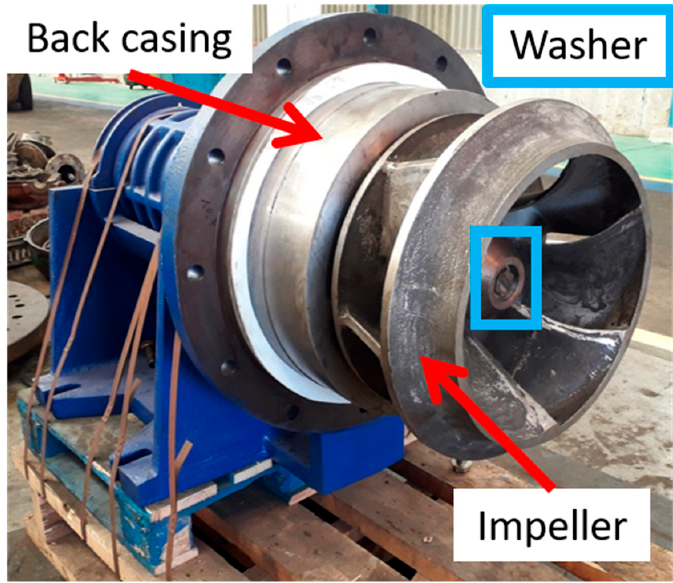
Metals 2023 , 13 , 216 Figure 4. Photo of radial pump cast in a Moroccan foundry. Figure 4. Photo of radial pump cast in a Moroccan foundry.